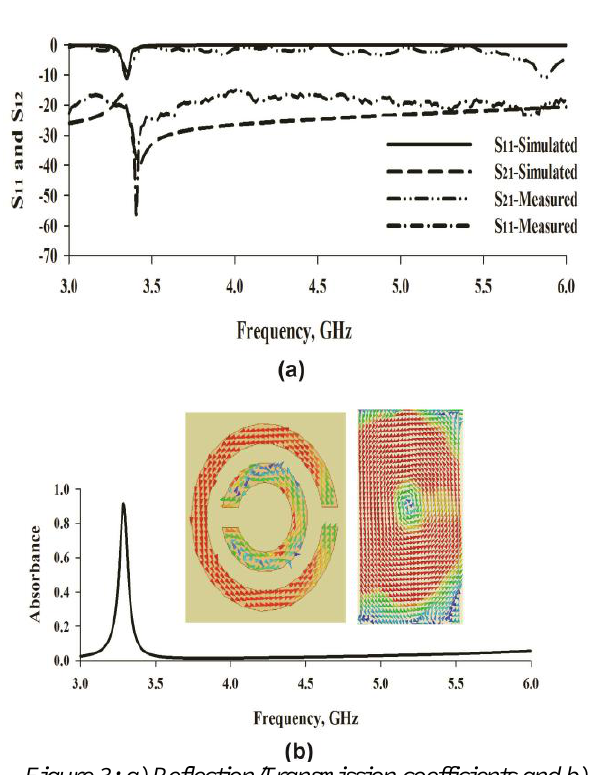
Figure 3: a) Reflection/Transmission coefficients and